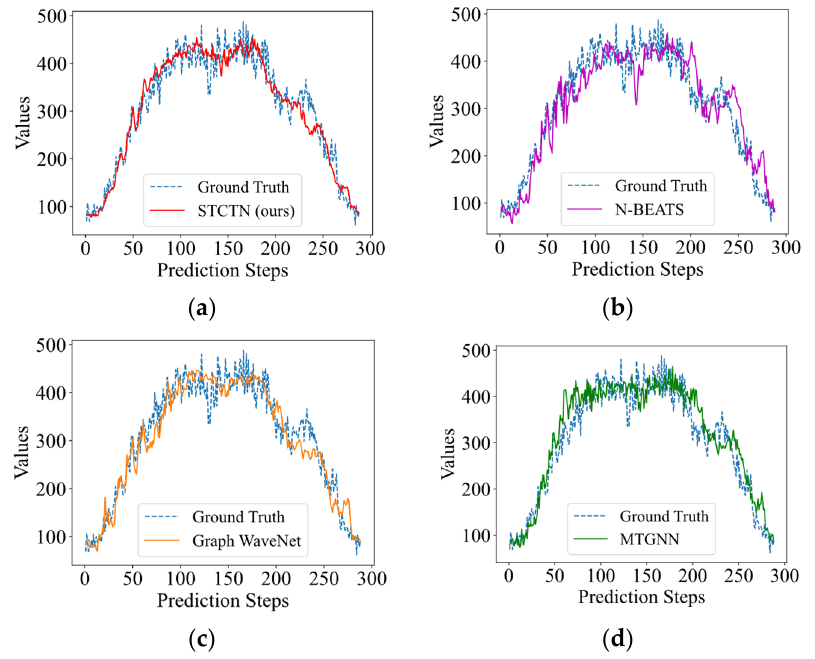
Figure 6. The long-term forecasting results (one day, 288 steps). ( a ) STCTN (ours); ( b ) N-BEATS; ( c ) Graph WaveNet; ( d ) MTGNN.